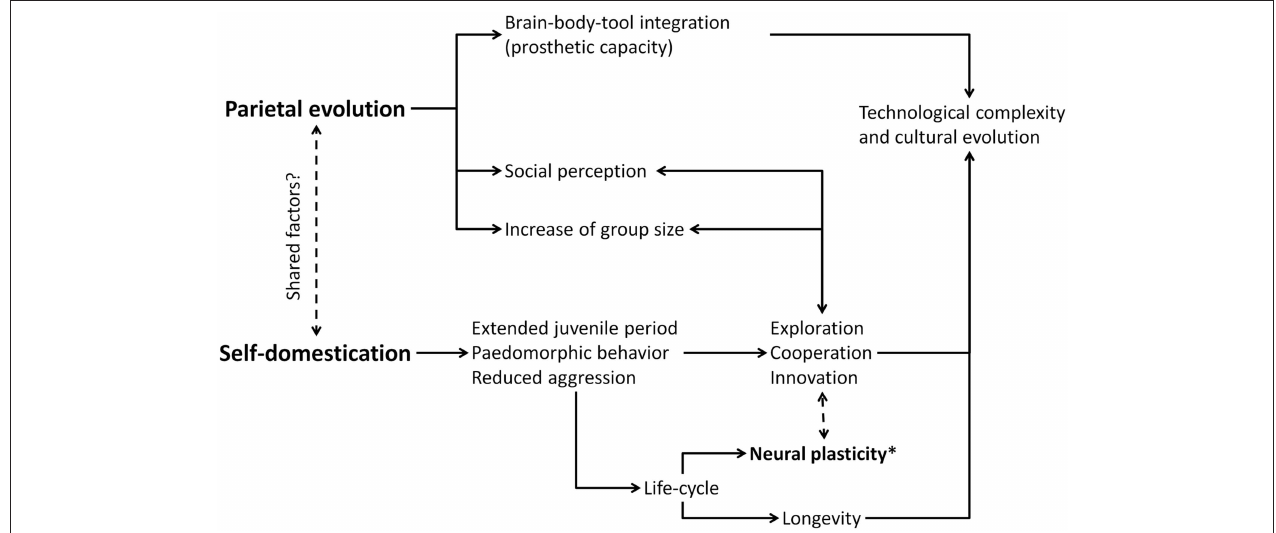
FIGURE 1 | Diagram of possible relationships between parietal evolution and self-domestication. Neural plasticity (*) can be a key factor, being targeted by selective processes as to enhance cognitive, cultural, and social